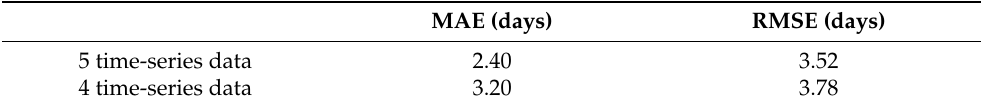
Table 6. Comparison of estimation accuracy of data obtained from the first four- and all five-time series.